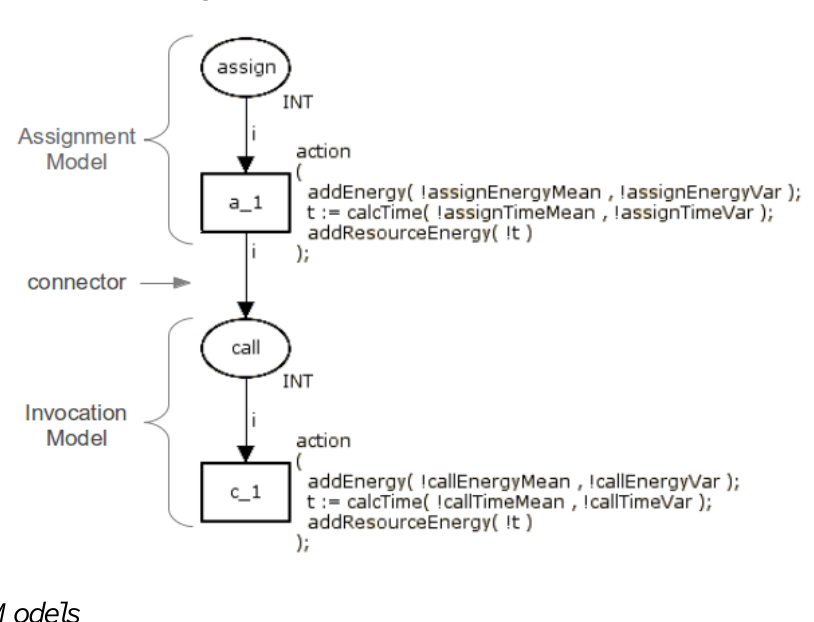
Figure 10. CPN Model of the function.